Question: What type of chart is this?
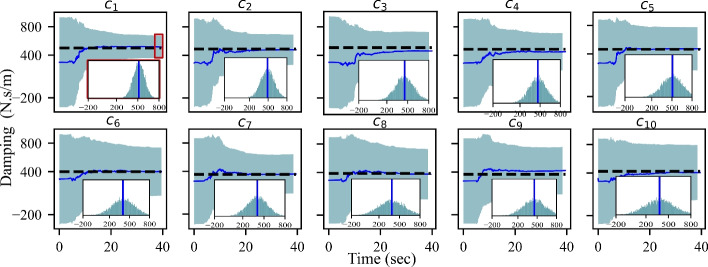
Answer: histogram